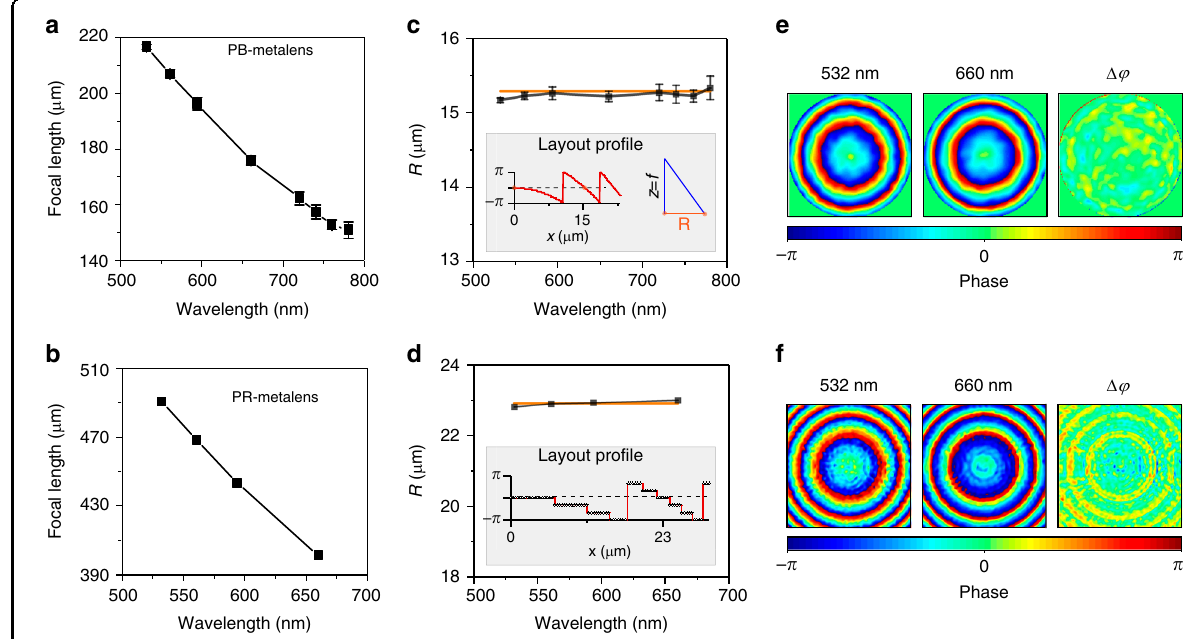
Fig. 3 Characteristics of the PB-metalens and the PR-metalens. Measured focal length of the PB-metalens ( a ) and the PR-metalens ( b ) as a function of incident wavelength. c Feature size R of the PB-metalens; the orange line is from SEM. The inset shows the sampled phase distribution from the layout (left) and a schematic diagram of the relationship between R and focal length f (right). d Feature size R of the PR-metalens; the orange line is from SEM. The inset shows the sampled phase distribution from the layout. e Phase distribution of the PB-metalens at 532 nm and 660 nm, and phase difference Δ φ . f Phase distribution of the PR-metalens at 532 nm and 660 nm, and phase difference Δ